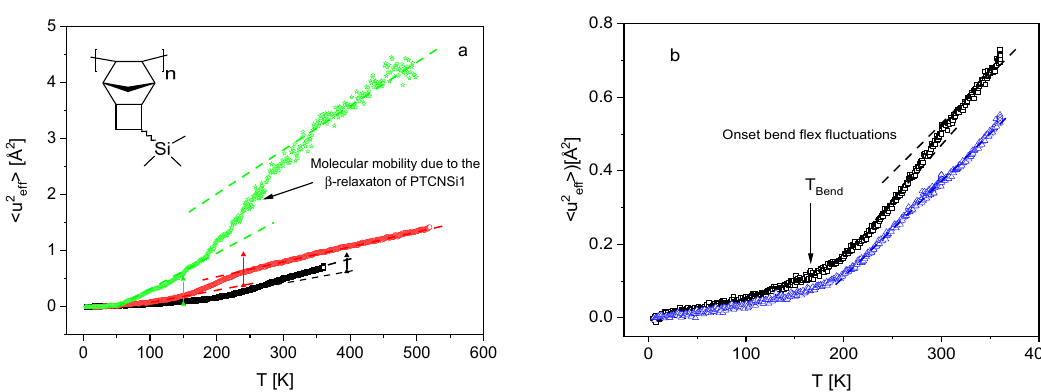
Figure 4. ( a ) Temperature dependence of <u 2 eff >: Black squares—PIM-EA-TB(CH 3 ), red circles—PIM-1 and green asterisks— PTCNSi1. The dashed lines are guides for the eyes. The vertical solid lines give the theoretical contribution of the methyl groups to <u 2 eff >. The color code is same than for the materials. ( b ) Comparison of <u 2 eff > for PIM-EA-TB(CH 3 ) (black squares) with that of PIM-EA-TB(H 2 ) (blue triangles). Lines are guides for the